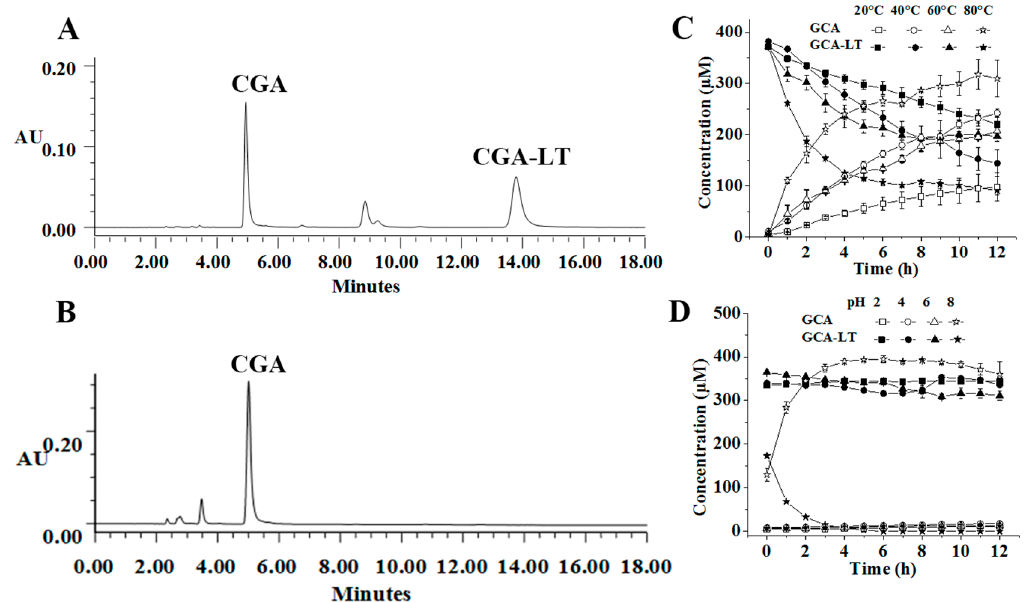
Figure 3. Representative UPLC chromatograms of trans -caffeoyl-6- O - D -glucono- γ -lactone (CGA-LT) in the exposed solution at 40 °C ( A ) and pH 8 ( B ) after 12 h; Time–concentration curves of CGA-LT and CGA at different temperatures ( C ) and pH values ( D ).